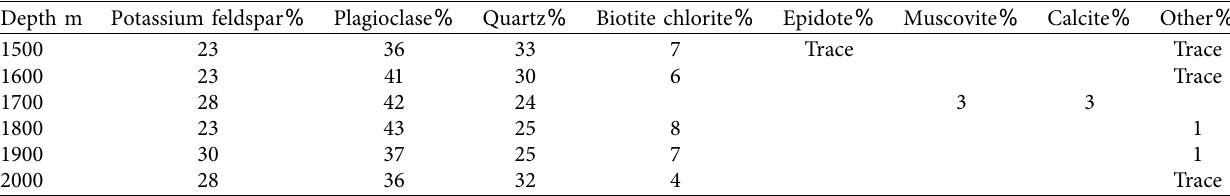
Table 3: The proportion of mineral composition of each group of rock samples.